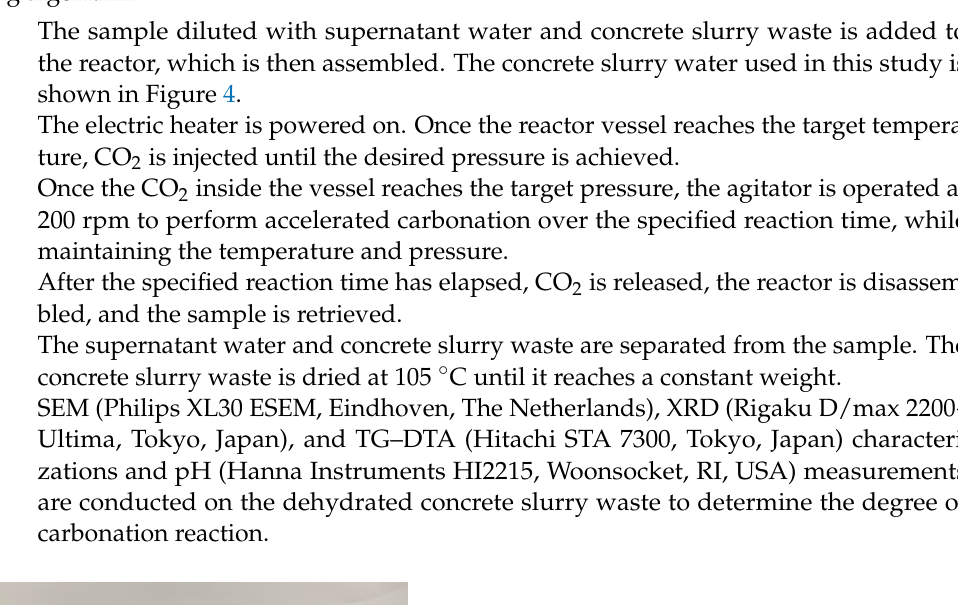
Figure 3. Schematic and photograph of the supercritical CO 2 reactor.